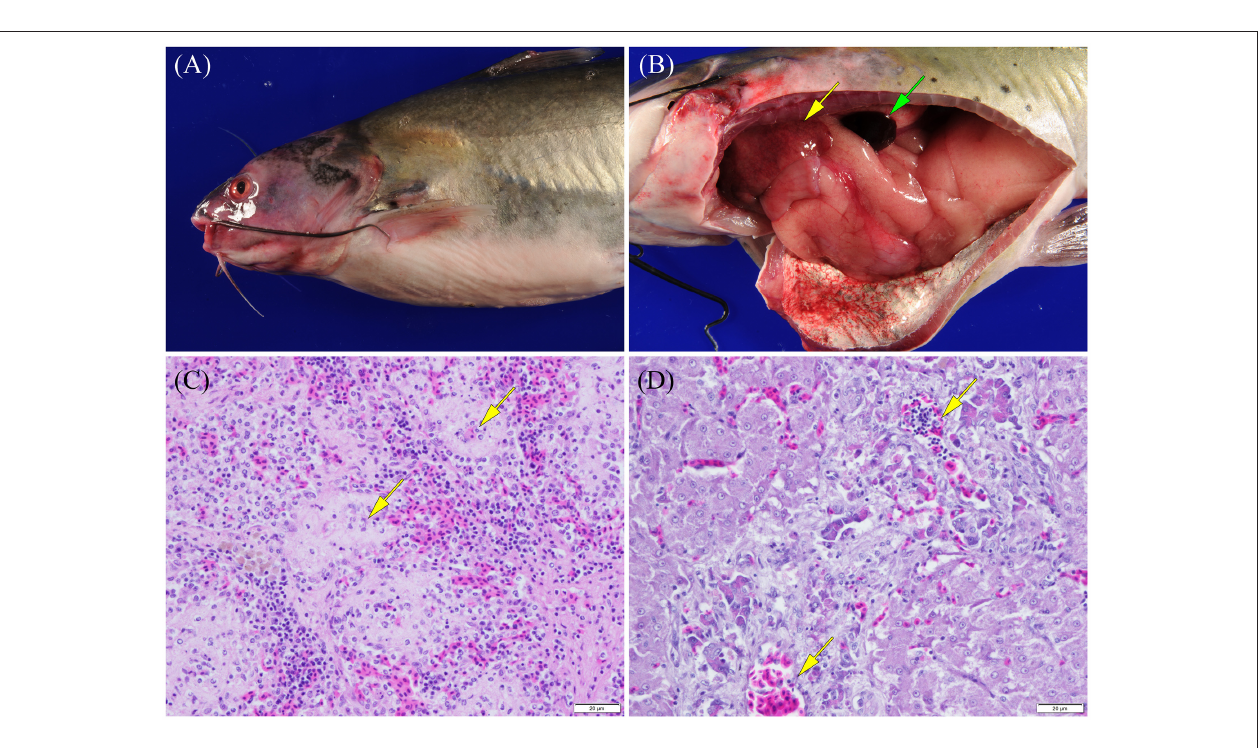
FIGURE 5 | Photographs of channel catfish infected by vAh showing (A) external surfaces that are exhibiting congestion/hemorrhage around the head/pectoral fin and within the eye and (B) the celomic cavity that has internal organs moderately congested and enlarged, a congested/hemorrhagic spleen (green arrow), and multifocal pale foci corresponding to areas of necrosis (yellow arrow) scattered over the liver (photographs courtesy of Dr. Wes Baumgartner, Mississippi State University) as well as photomicrographs of a channel catfish infected by vAh strain ML09-119 showing (C) a section of spleen with splenic ellipsoids (arrows) that are edematous and ellipsoidal arteries that are lined by degenerating as well as necrotic endothelial cells and (D) a section of liver with edema and necrosis of pancreatic acinar tissue surrounding branches of the hepatic portal vein